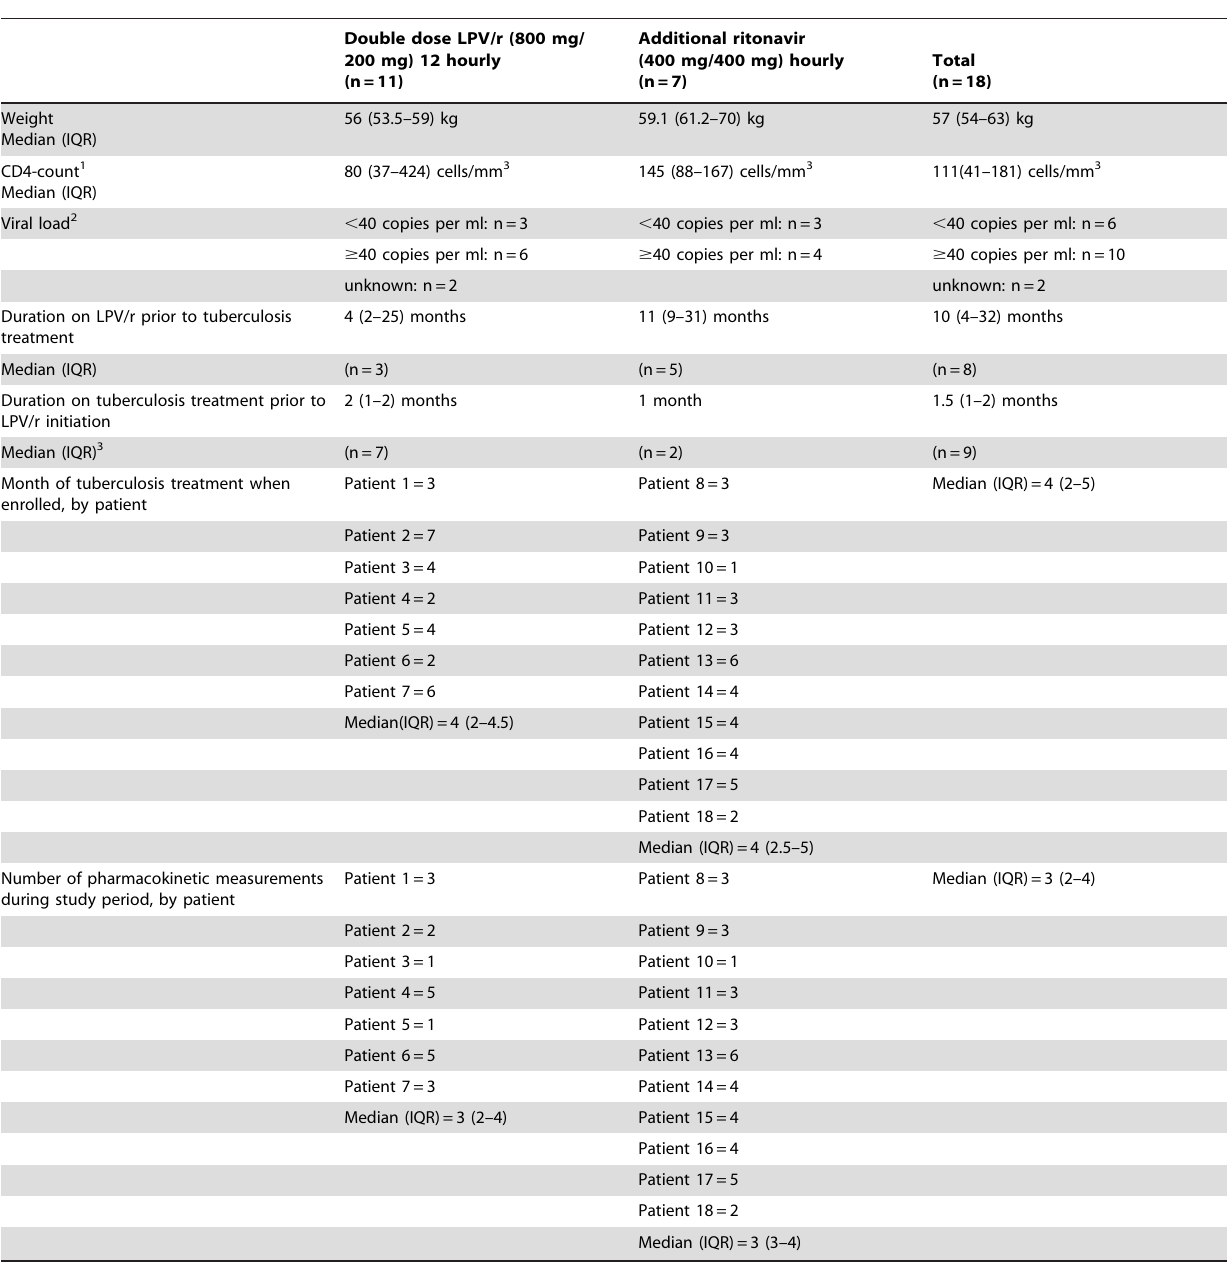
Table 1. The baseline characteristics of the enrolled